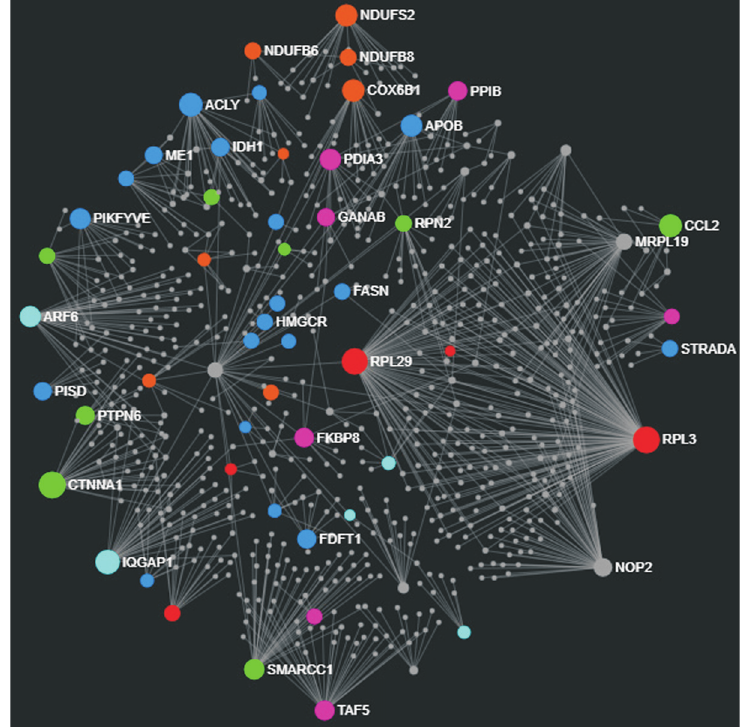
Figure 5 - Enriched hubs highlighting the main biological processes in the protein interaction network of the Balbina population. Hubs with different col- orsrepresentpriorpathways;orange–energymetabolism,darkblue–lipidmetabolism,lemongreen–reproductiveprocess,lightblue–RNAmetabolic process, pink – protein folding, and red – intracellular protein transport. Smaller grey hubs reflect interacting non-differentially expressed genes.